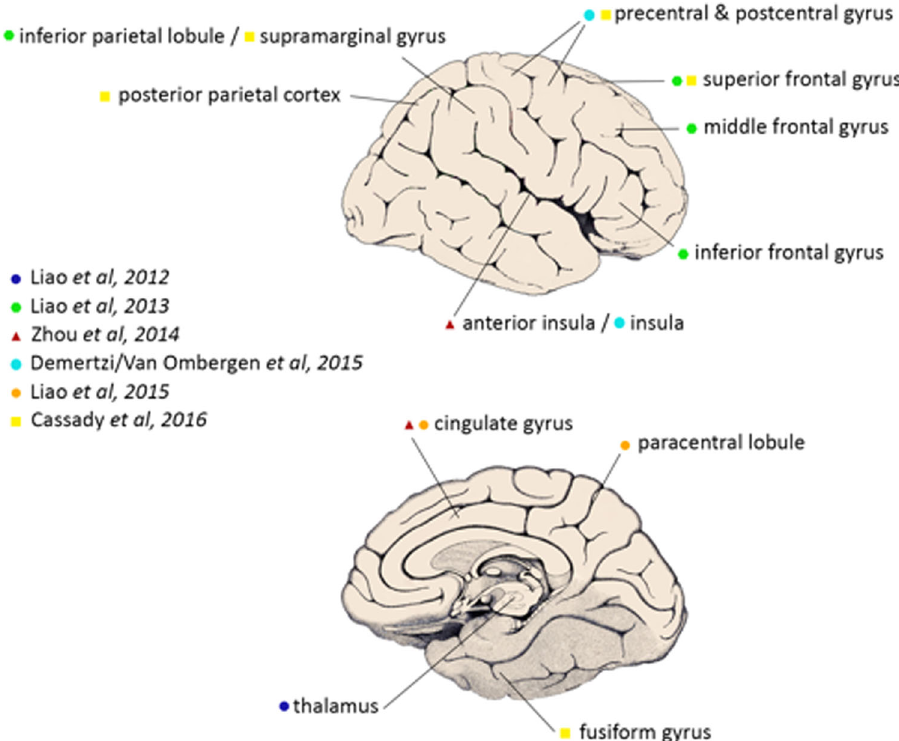
Fig. 2 Cortical and subcortical brain areas most affected by space fl ight analogs or actual space fl ight, as described in the rsfMRI studies discussed in this review ( fi gure modi fi ed after 26 , with permission, originally from 111 ). For simpli fi cation, laterality of the fi ndings was not taken into account. A more extensive description of the fi ndings can be found in Table 1